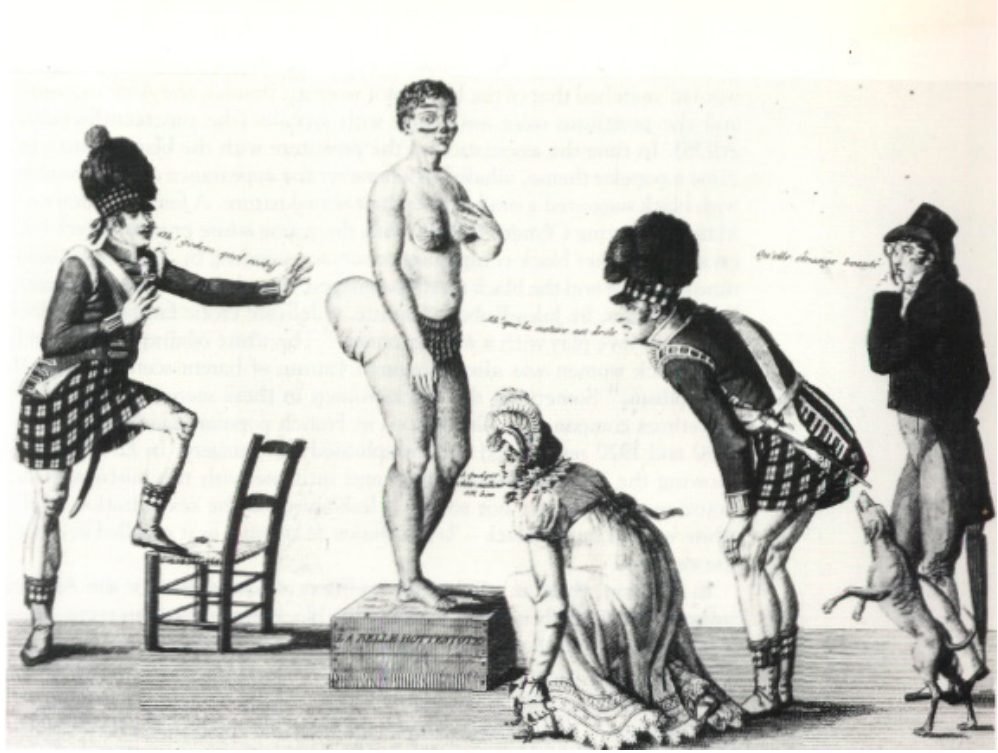
Figure 1. French Cartoon, Les Curieux en extase ou les cordons de souliers , 1814 (available in public domain).